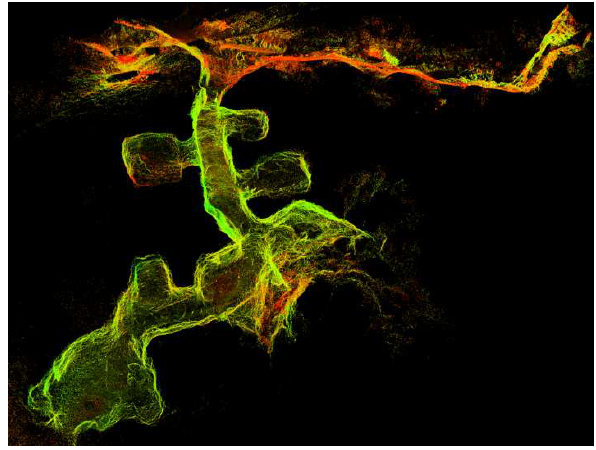
Figure 12. Visualization of the tunnel with the adjoining rooms and entrenches.